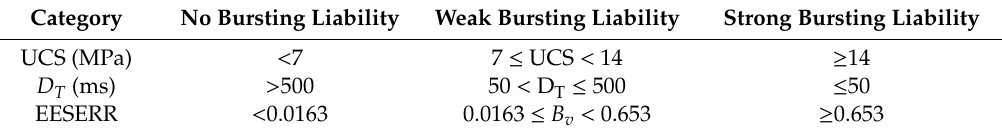
Table 1. Threshold values for bursting liability as determine by the e ff ective elastic strain energy release rate (EESERR)